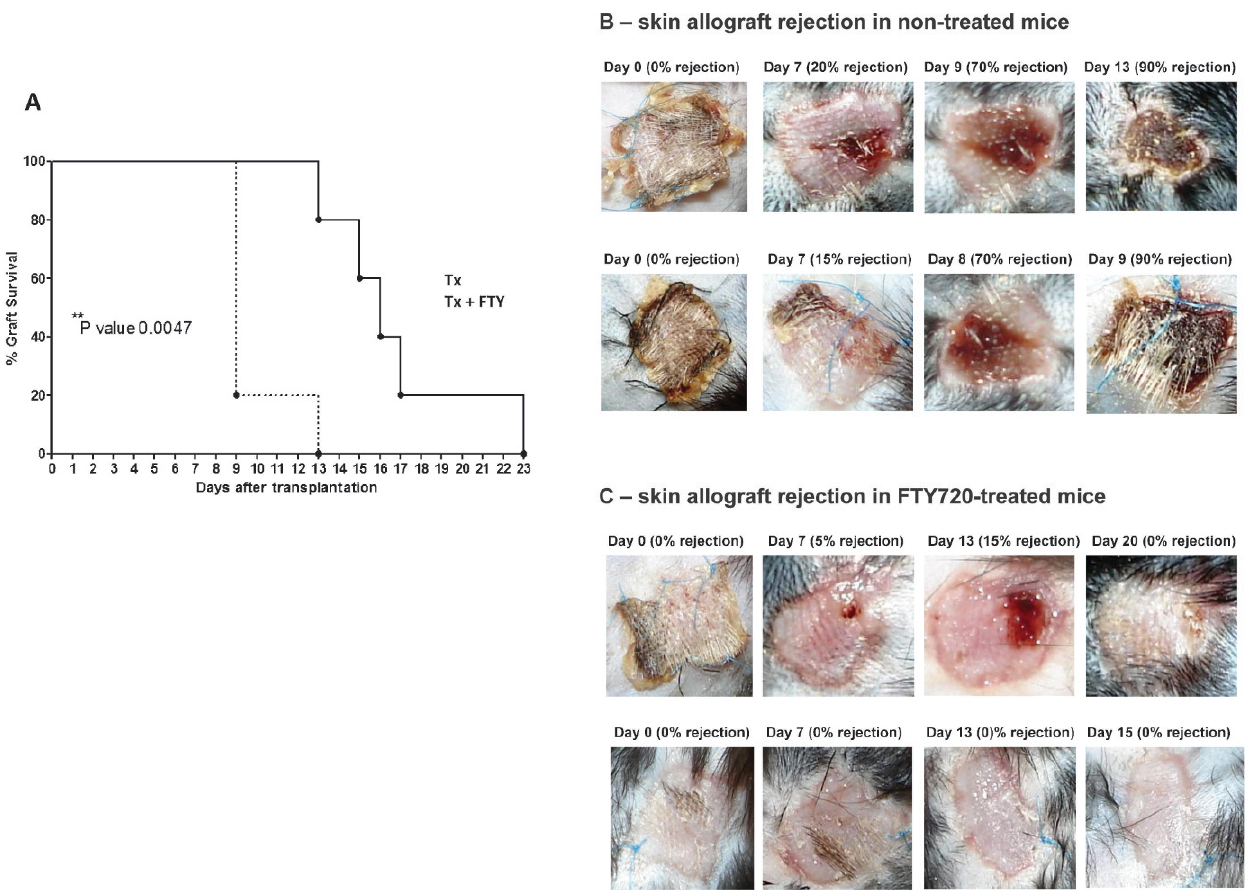
Figure 1 - FTY720 treatment prolongs mouse skin allograft survival. F1 (BALB/c x C57BL/6) mice were donors to C57BL/6 recipients, and skin allograft rejection was determined macroscopically when the graft reached a necrosis level of 90%. A - Kaplan-Meier curve of skin allograft survival showing that FTY720 treatment significantly increased the survival of F1 (BALB/c x C57BL/6) skin allografts in the C57BL/6 recipients. B - The macroscopic signs of rejection were observed as early as day 7 in transplanted, non-treated (Tx) mice. C - Rejection signs occurred later in the transplanted, FTY720-treated (Tx + FTY)